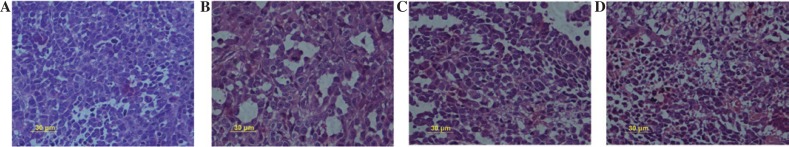
SN50-induced cell death of transplanted SGC7901 tumor cells. Pathological changes in the SGC7901 tumor cells in (A) the model control and (B–D) experimental groups. (B) 5, (C) 10 and (D) 15 days after treatment with SN50. Hematoxylin and eosin (HE) staining; magnification, x200.